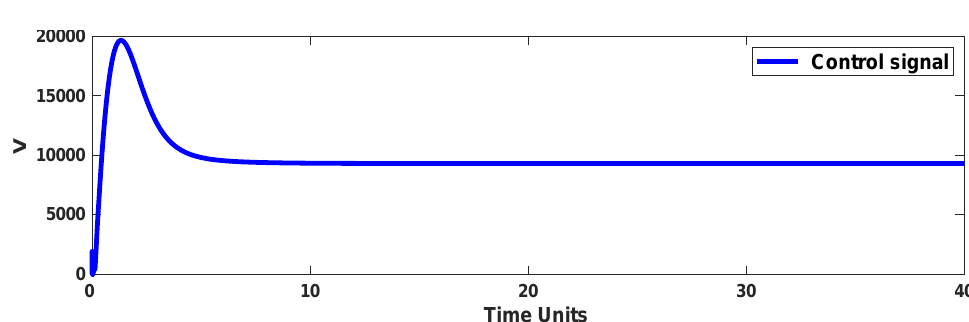
Figure 6. Stator current (( i sq )) in the normal condition.